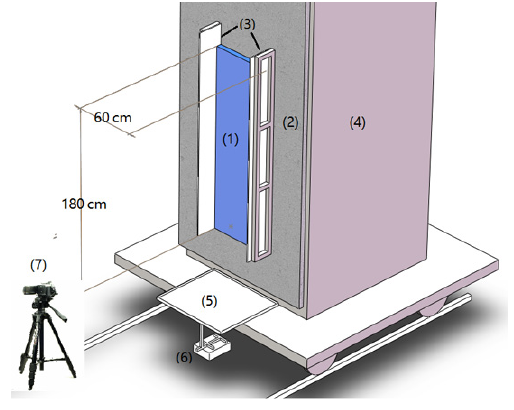
Fig. 2. Schematic diagram of experimental apparatus: (1) XPS foam slab, 60 cm wide, 180 cm high and 5 cm thick; (2) Calcium silicate board; (3) Sidewalls with steel frame, various widths; (4) Back bone facility; (5) Aluminum foil pan; (6) Electronic balance; (7)